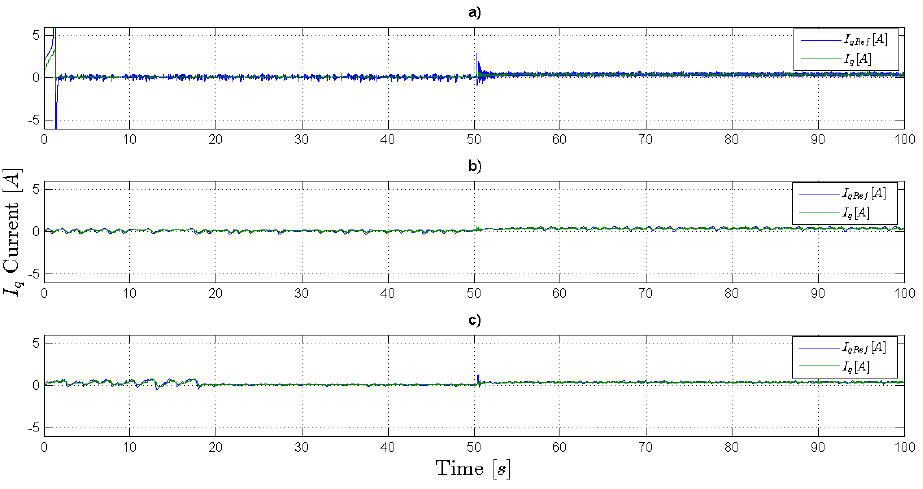
Figure 5. I q currents of the closed-loop systems when the velocity is controlled to 0.3142 rad/s. ( a ) FSLC as the velocity controller; ( b ) PI as the velocity controller and ( c ) ANN as the velocity controller.